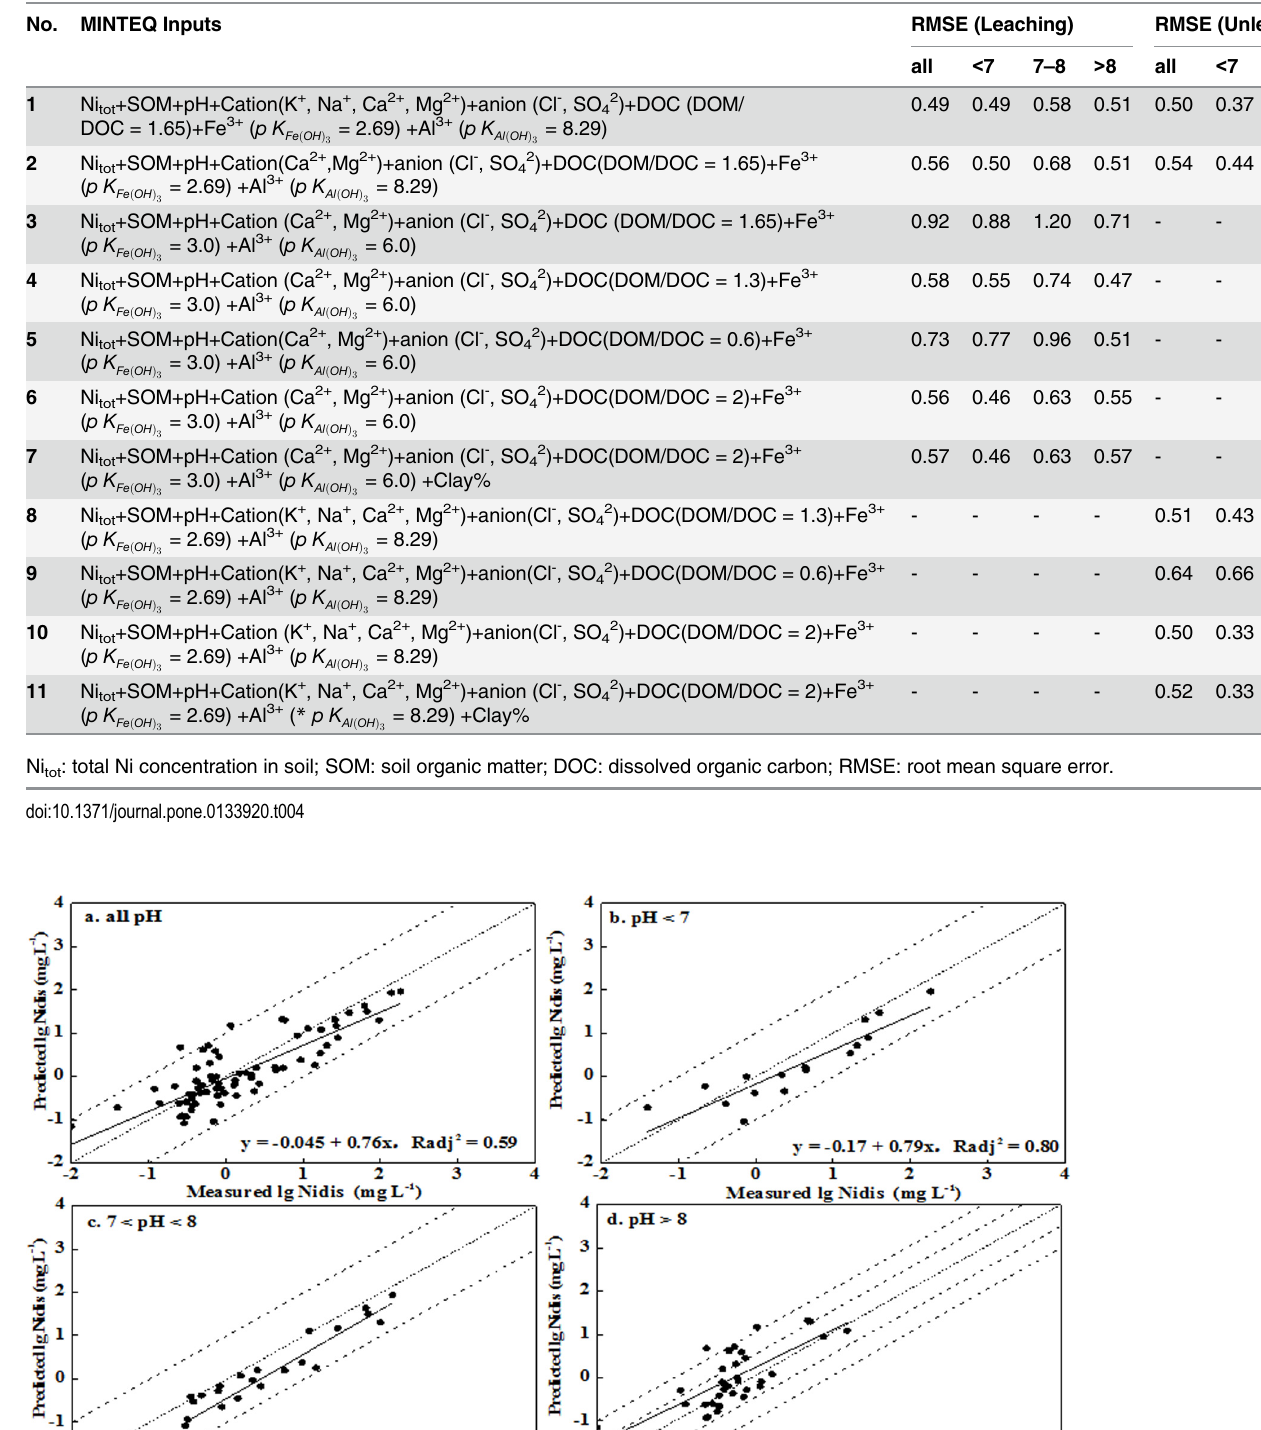
Table 4. Effects of the input variables on the RMSE between the predicted soluble Ni concentrations by Visual MINTEQ and measured values.